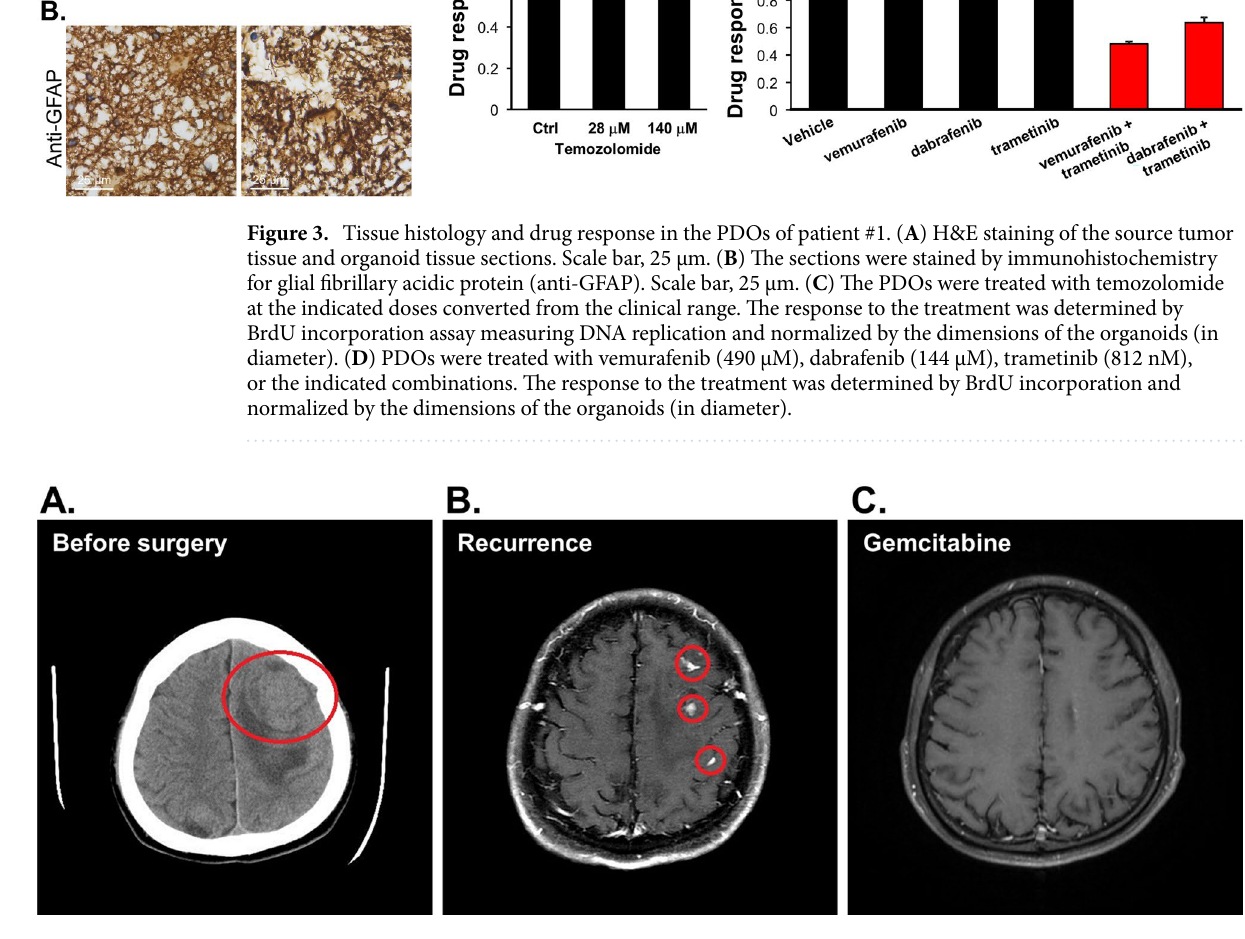
Figure 4. Radiological response of the brain lesion of patient #2 to gemcitabine. ( A ) A computed tomography (CT) scanning before surgery; the tumor areas are circled. ( B ) Residual lesion revealed by MRI of patient’s brain in a follow-up after surgery. ( C ) Follow-up axial MRI of the brain. The patient shows complete response after gemcitabine